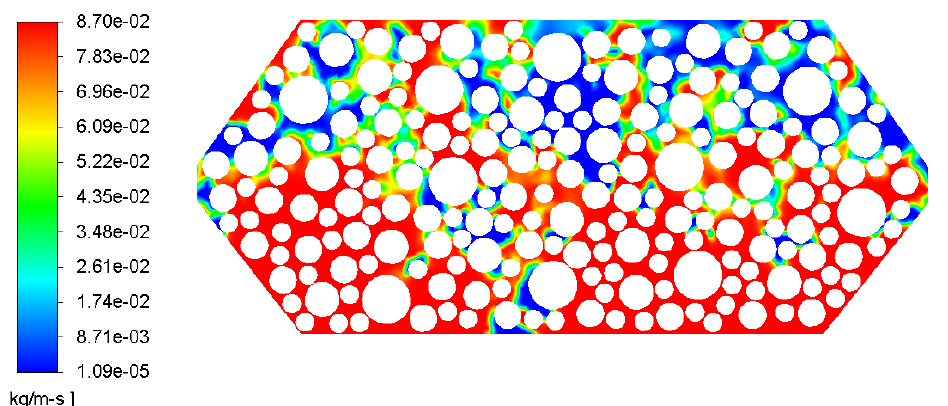
Figure 17. Contours of viscosity for case 1 at 300 s.